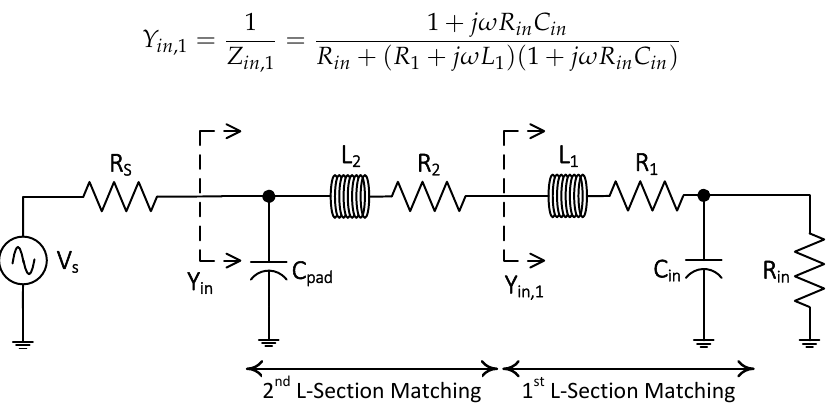
Figure 6. π -matching network thought of as cascaded L -section matching networks.